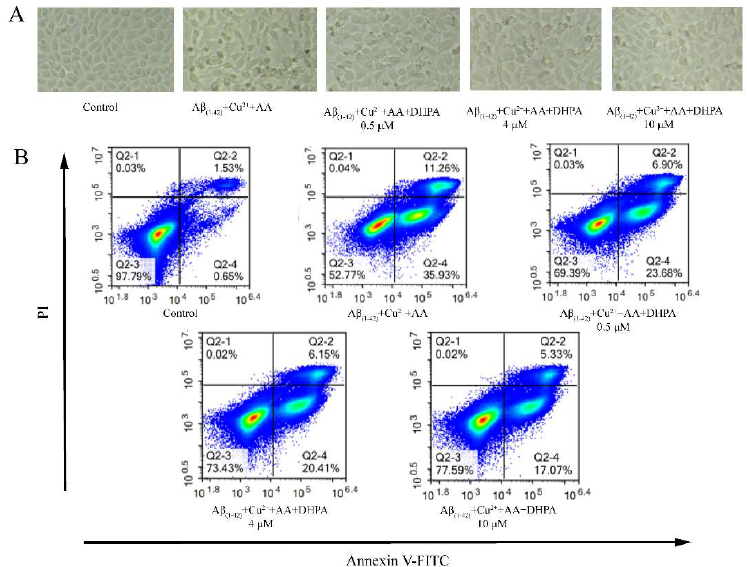
Figure 2. The effects of DHPA on the cell apoptosis of Aβ (1 － 42) /Cu 2+ /AA-induced SH-SY5Y cells. Cell morphology ( A ). Apoptosis rate detected with flow cytometry ( B ). Cell morphology ( A ). Apoptosis rate detected with flow cytometry ( B